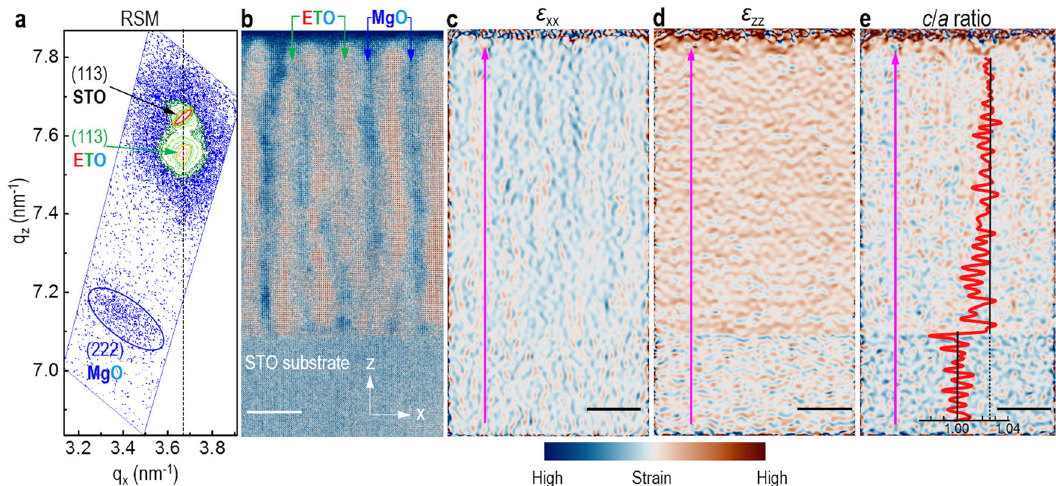
Fig. 2 Strain analysis of an ETO:MgO VAN fi lm. a Reciprocal space map of (113) Bragg re fl ection of ETO and STO, and (222) Bragg re fl ection of MgO. b Colored HAADF-STEM image of the VAN fi lm in cross-section. Respective IP ( ε xx ) ( c ) and OOP ( ε zz ) ( d ) strain maps obtained from STEM-based GPA. The lattice of the STO substrate was taken as a reference for strain analysis. e The corresponding c / a map calculated with ( c , d ). The inset shows a pro fi le of c / a ratio extracted along the arrow direction. Scale bar: 20 nm.